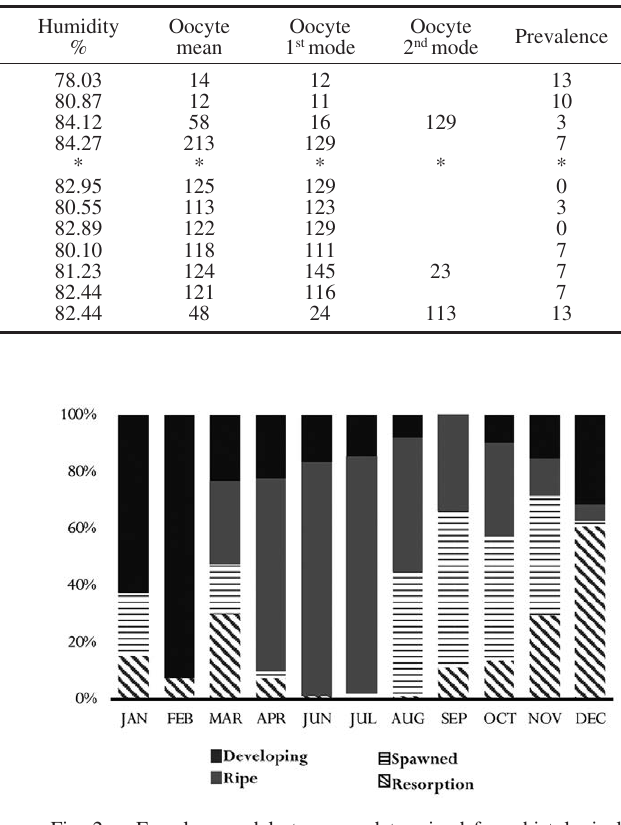
Fig. 2. – Female gonadal stages as determined from histological analysis . Key to bar textures: black, developing; grey, ripe; cross- hatched, spawned; diagonally hatched, resorption.